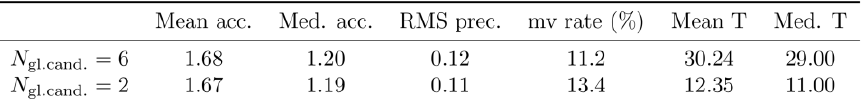
Table 5. The result of comparing two different values for N_(gl.cand.), using all the data. The columns refer to mean and median accuracy, RMS precision, missing value rate, and mean and median computation times of single frame in milliseconds. The unit of accuracy and precision is degrees. Lower values are